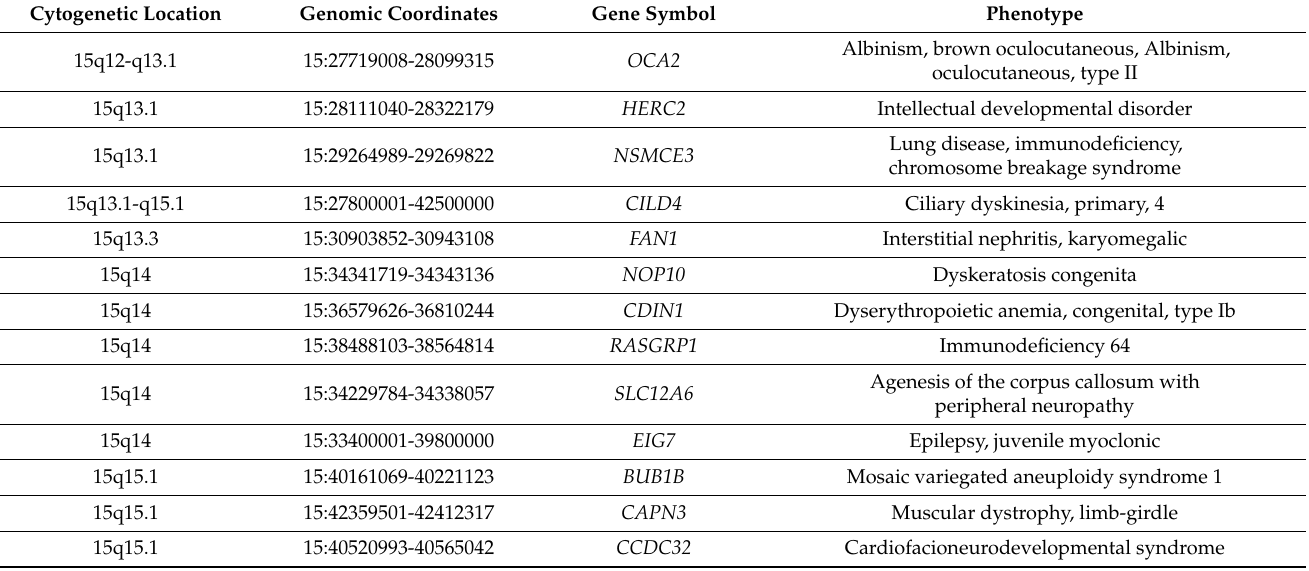
Table 1. Autosomal Recessive Genes and Location on Chromosome